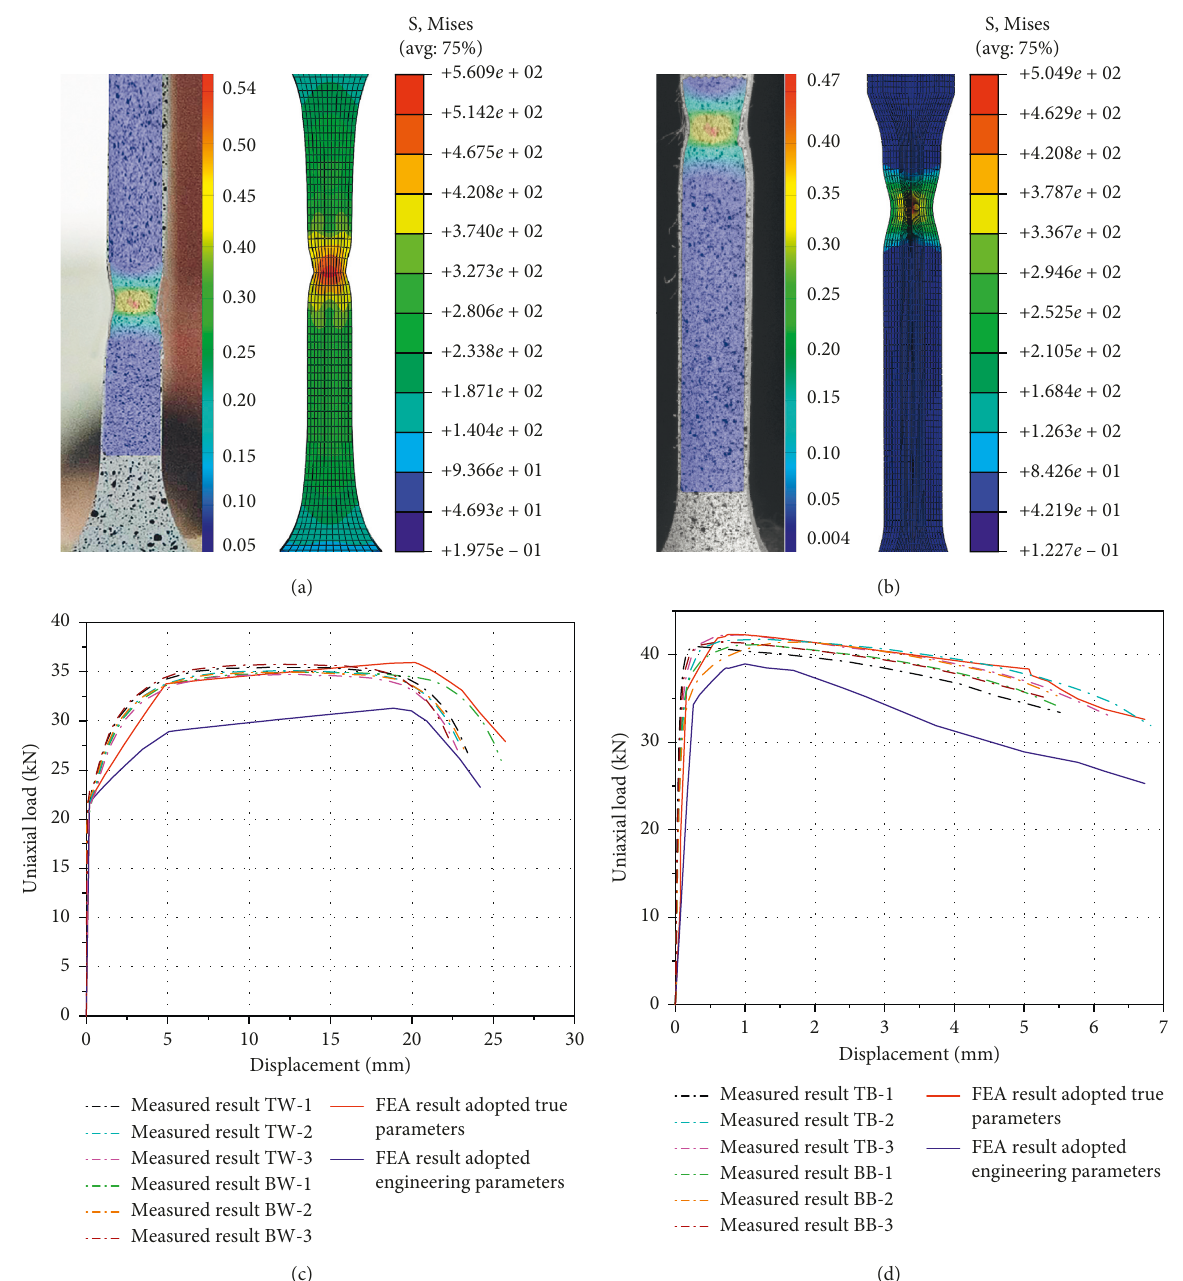
Figure 17: Comparison of numerical and experimental results: (a) failure states of flat coupon; (b) failure states of corner coupon; (c) load- displacement curves of flat coupon; (d) load-displacement curves of corner